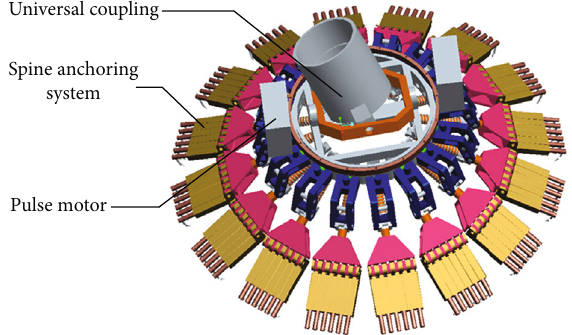
Figure 9: Mechanism of the spine anchoring